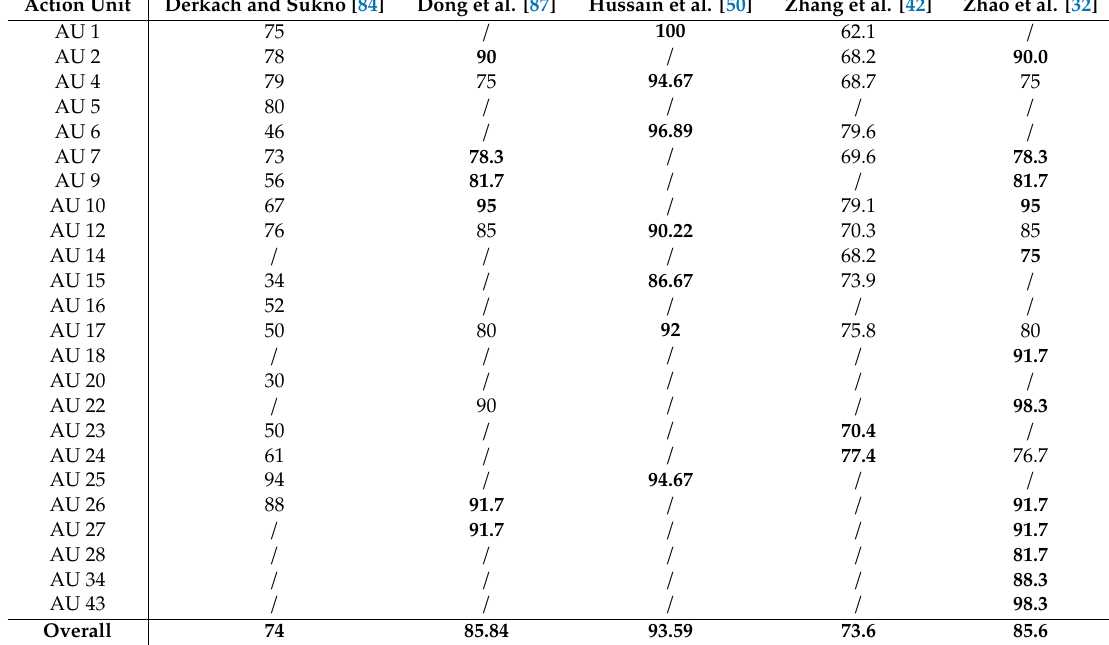
Table 6. Recognition rates (RRs) in the presence of di ff erent action units and the overall average result obtained. For each type of AUs, the best result is written in bold